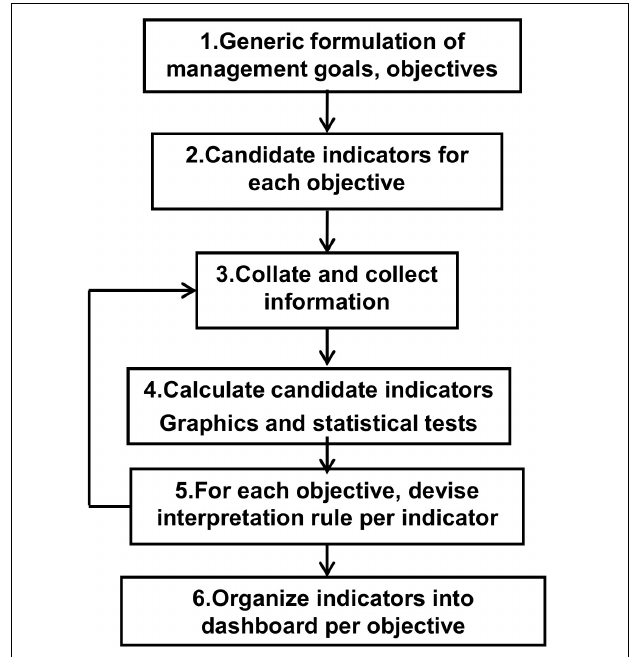
FIGURE 2 | Consensus indicator approach for Project